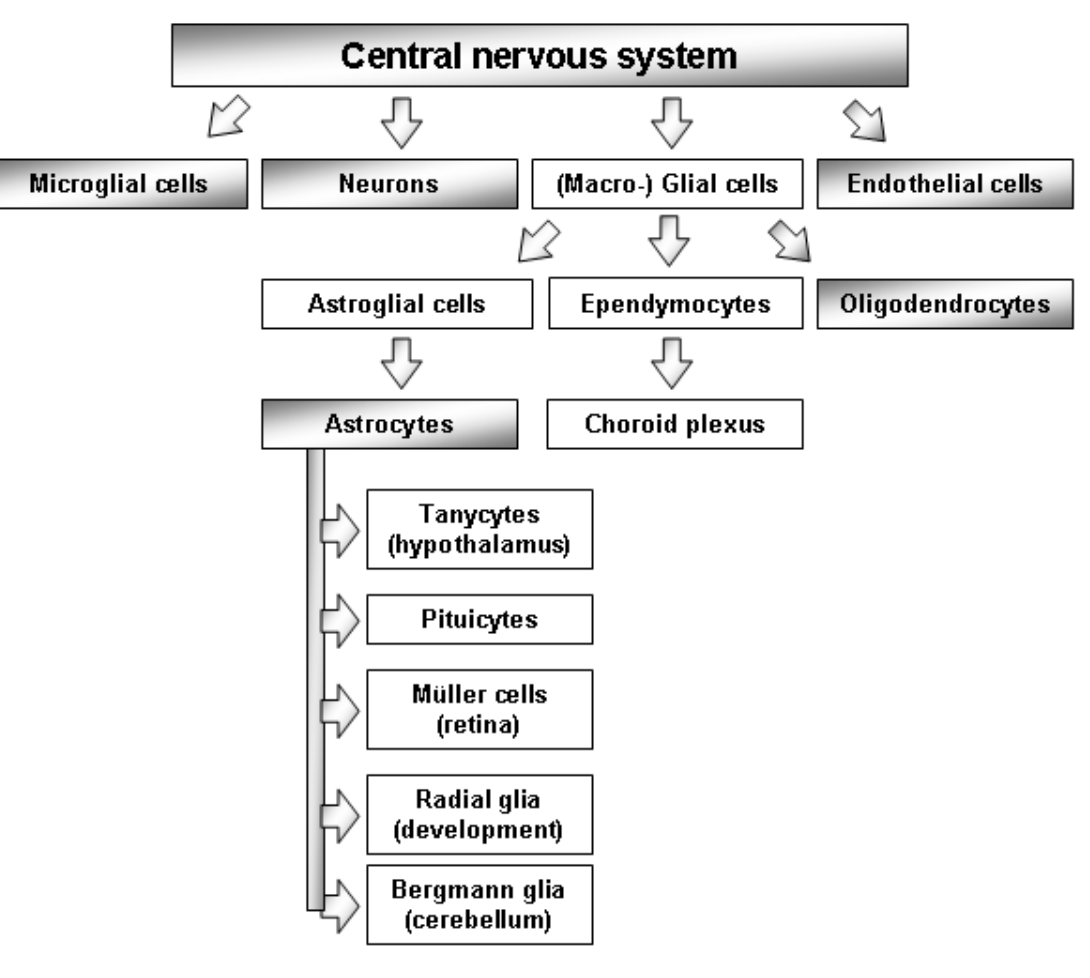
FIGURE 1. Schematic overview of the nomenclature of the major cell types in the CNS. Nomenclature of the glia cell family is sometimes especially confusing. Shadowed boxes are the major cell types in the brain parenchyma (and are the names of the cells that will be referred to in the review). Microglial and endothelial cells are thought to be of mesenchymal origin while the other cell types are of neuroectodermal origin. The choroid plexus may be regarded as a specialized outgrowth of ependymocytes making up the blood-CSF